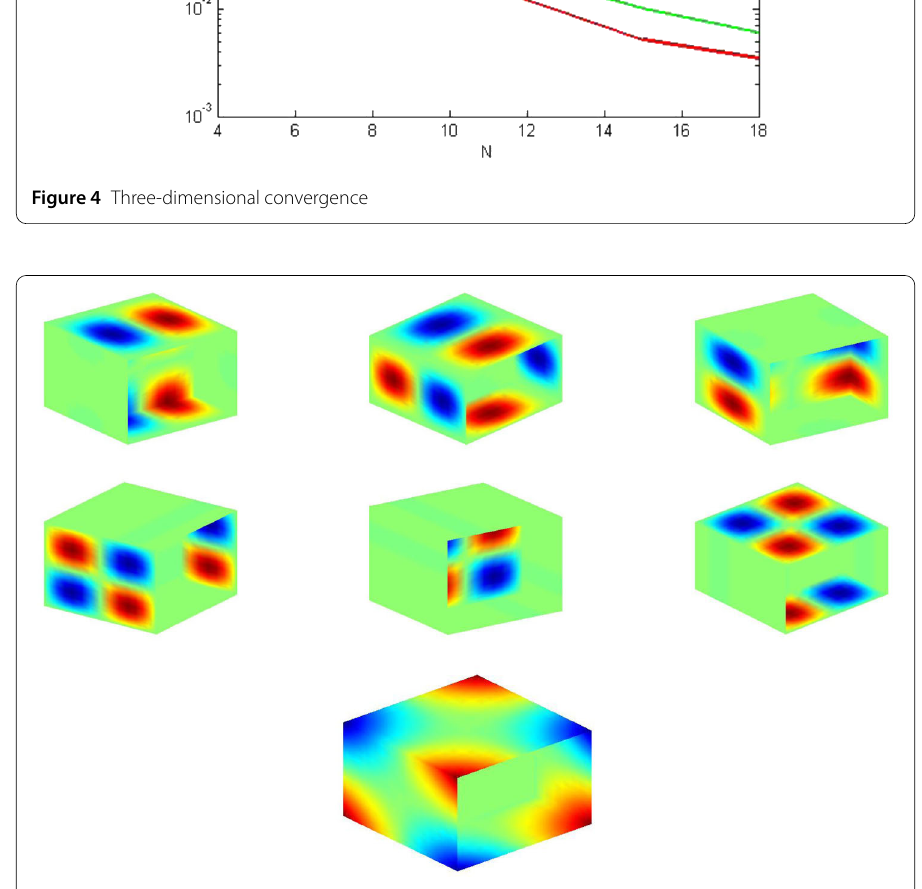
Figure 5 The three-dimensional discrete solution for the data defined in (39)